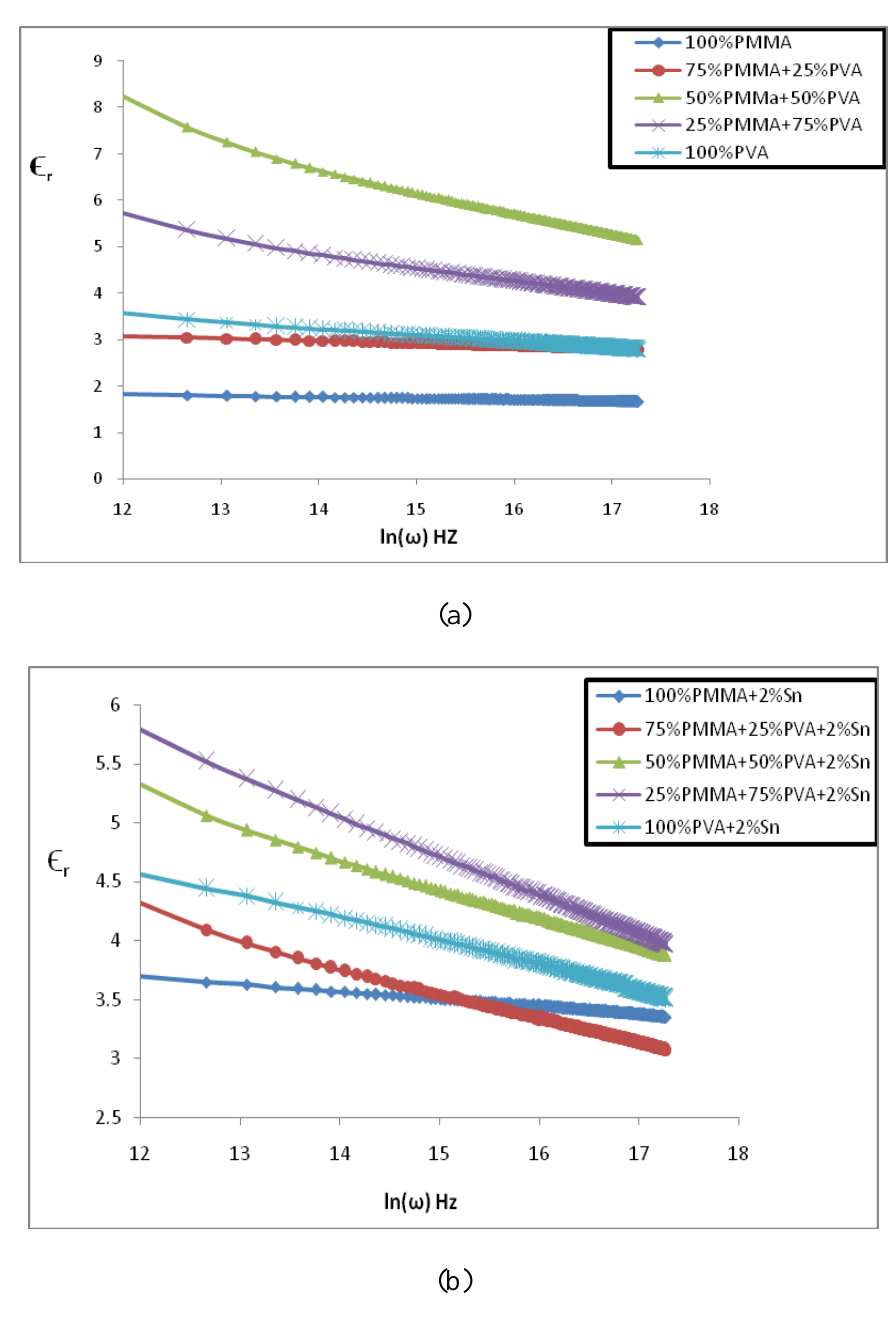
Fig.1: Variation of ϵ